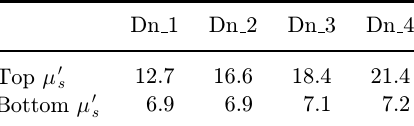
Table 2. (cid:1) 0 s of base-down models (cm (cid:1) 1